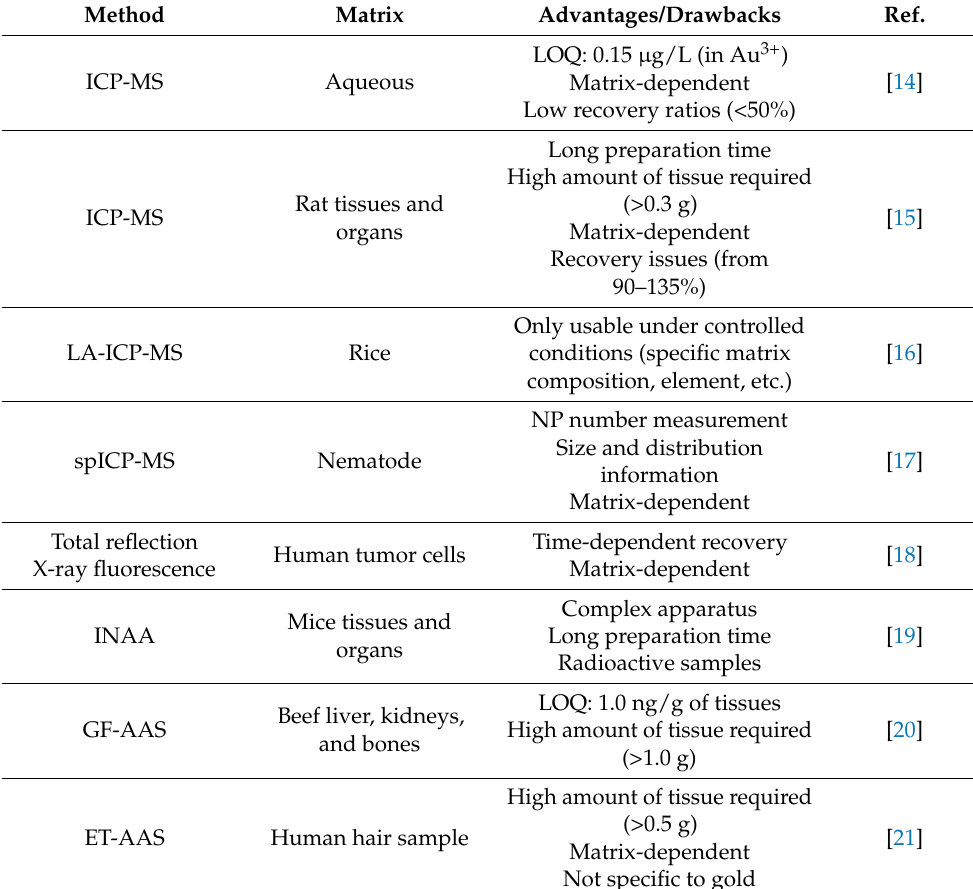
Table 1. Analytical methods for gold quantification in biological